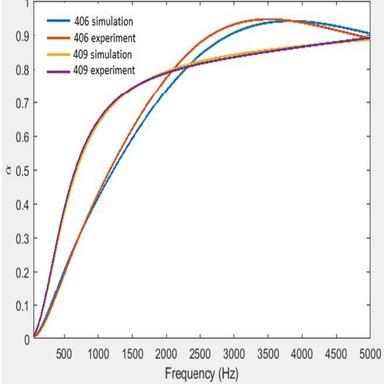
Normal sound absorption coefficient spectra for sample 406 and 409 - The JCA model was used for a frequency range between 50 Hz and 5000 Hz with a 50 Hz step.